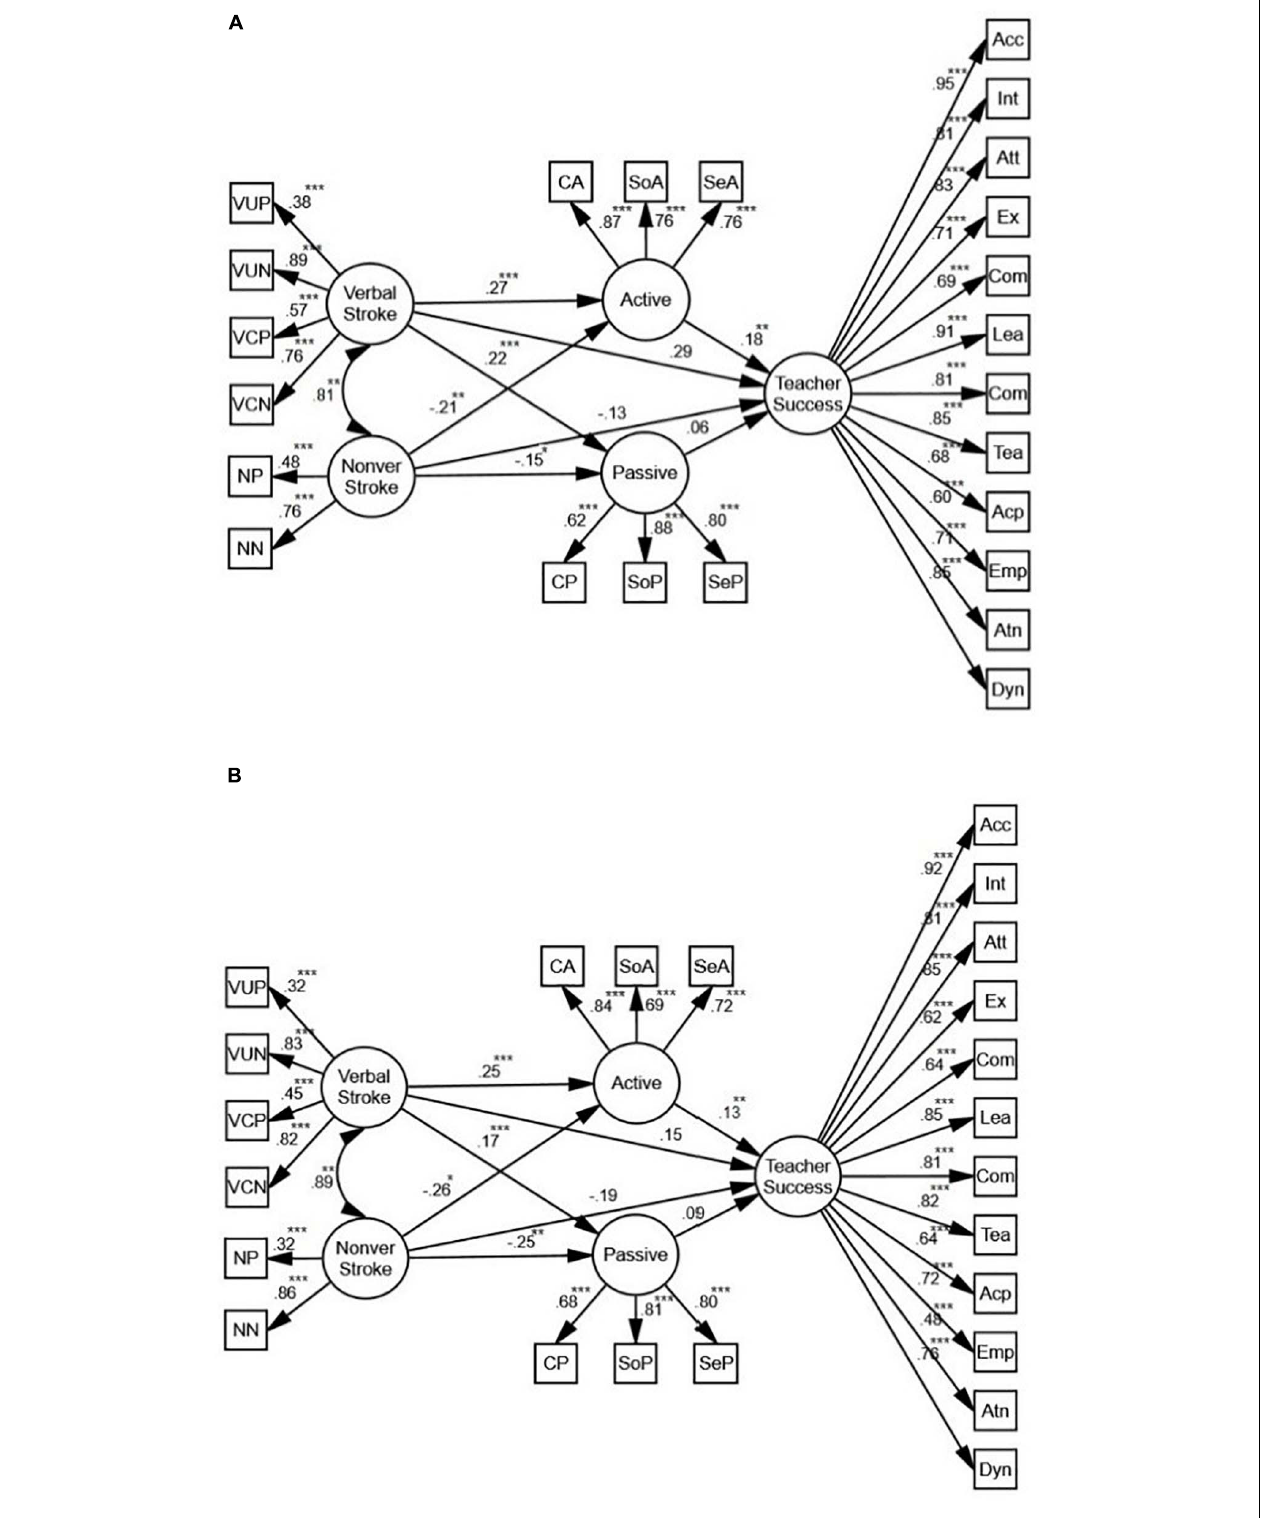
FIGURE 7 | (A) The schematic representation of the relationships between verbal and nonverbal (nonver) stroke, active and passive motivation, and teacher success (Females). (B) The schematic representation of the relationships between verbal and nonverbal (nonver) stroke, active and passive motivation, and teacher success (Males) (* p < 0.05, ** p < 0.01, *** p < 0.001).